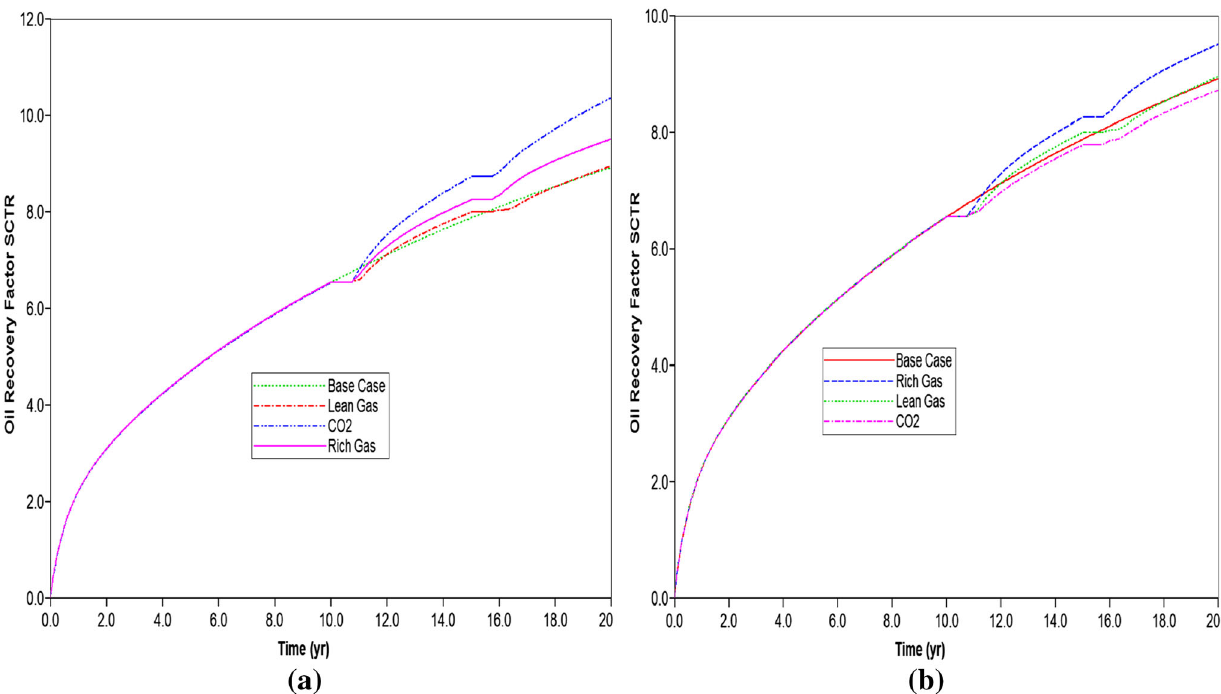
Fig. 13 Miscible gases performance in Bakken model for the 2nd scenario. a Molar diffusion mechanism is ON. b Molar diffusion mechanism is OFF